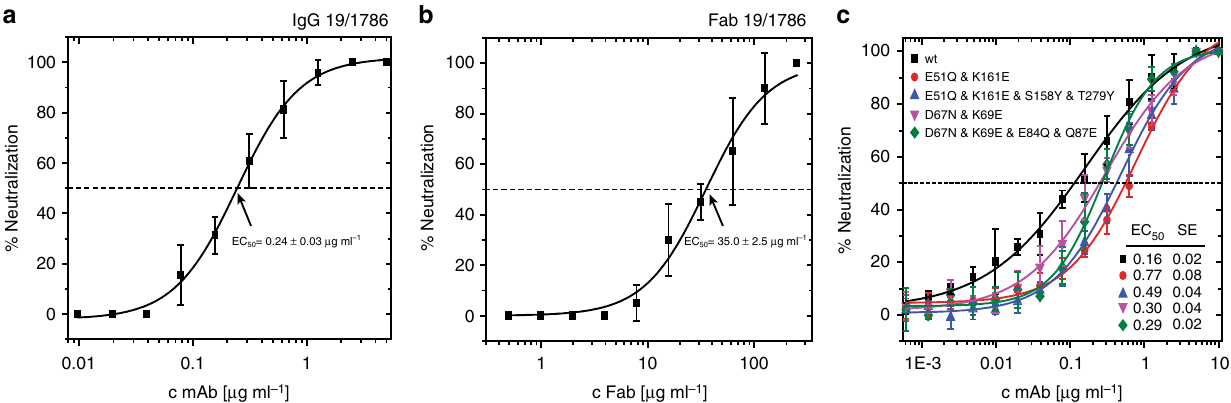
Fig. 3 Neutralization of TBEV by antibody 19/1786. Dose-dependent neutralization curves of TBEV treated with IgG 19/1786 ( a ) and Fab 19/1786 ( b ). Error bars represent standard deviation of the measurements (IgG n = 5; Fab n = 2). EC 50 values with standard error of the mean are shown in the graph. c Dose- dependent neutralization curves of TBEV and its mutants treated with IgG 19/1786. Mutations in domain I (red circle — double mutant; blue triangle — quadruple mutant) and domain II (magenta triangle — double mutant; green diamond — quadruple mutant) affect the neutralization activity of Fab 19/1786 compared to the wild-type virus (black square). The mutations in the domains are listed in the top left corner. The error bars represent the standard deviation of the measurements ( n = 3). Calculated EC 50 values ( µ g ml − 1 ) with standard errors are listed in the bottom right